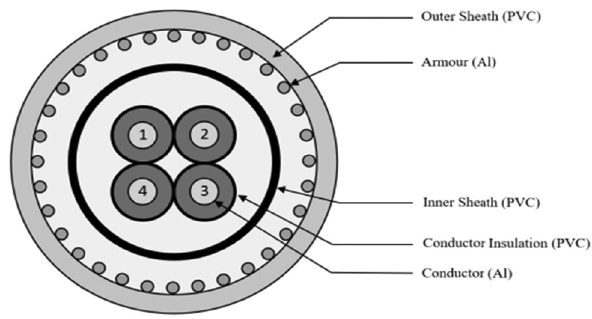
Figure 1: Four core sector -